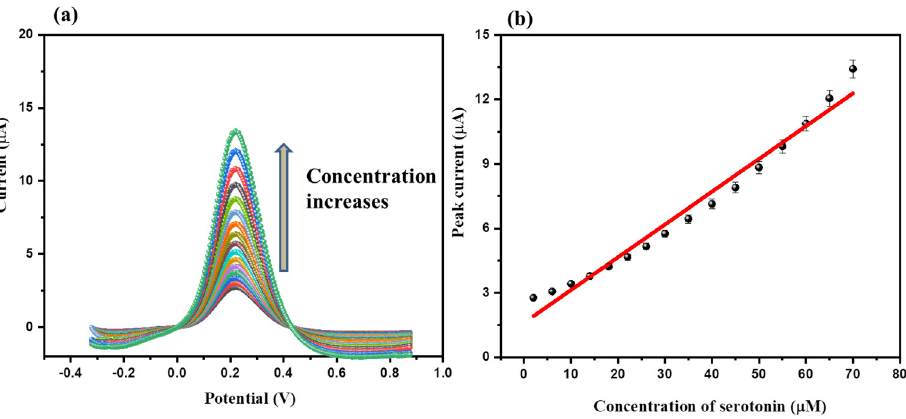
Figure 9. DPVs ( a ) of MGCE in various concentrations (2 µM, 6 µM, 10 µM, 14 µM, 18 µM, 22 µM, 26 µM, 30 µM, 35 µM, 40 µM, 45 µM, 50 µM, 55 µM, 60 µM, 65 µM, and 70 µM) of serotonin in 0.1 M PBS (pH = 7.0) at scan rate of 50 mV/s. Calibration plot ( b ) between current response versus concentration of serotonin.